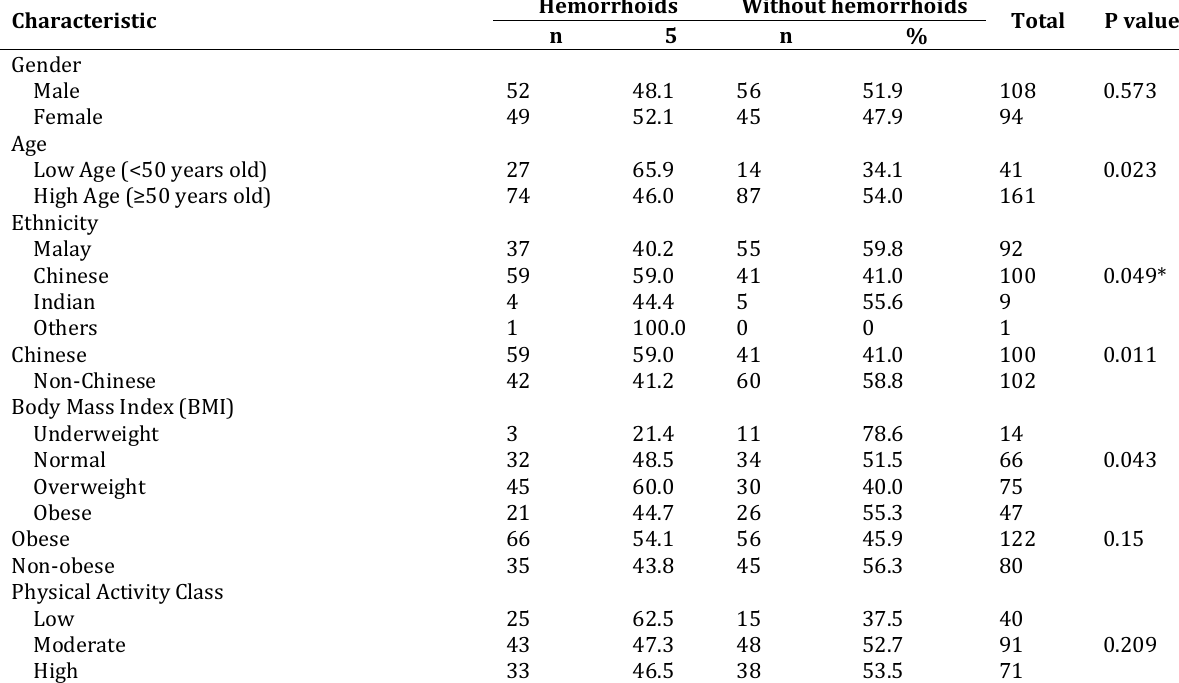
Hemorrhoids Without